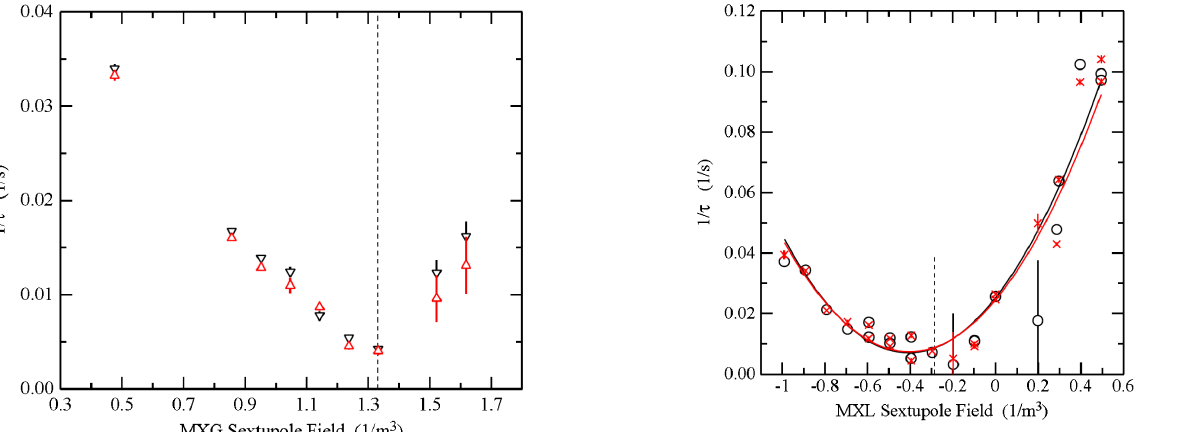
FIG. 23. Measurements of 1 / τ as a function of changing MXK field for S ¼ 6 . 04 m − 3 and G ¼ 0 m − 3 . The black circle points are for polarization negative and the red X points for polarization positive. The dashed line marks the point chosen to bring the x and y chromaticities close together. The corresponding parabolic curves are a guide to the eye for each polarization